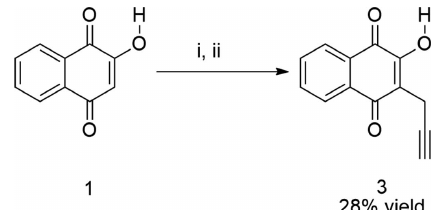
Figure 3 The synthetic scheme of the title compound, 3 ; (i) propargyl bromide, sodium iodide and dry acetone, 0.5 h; (ii) diisopropylethylamine and t -